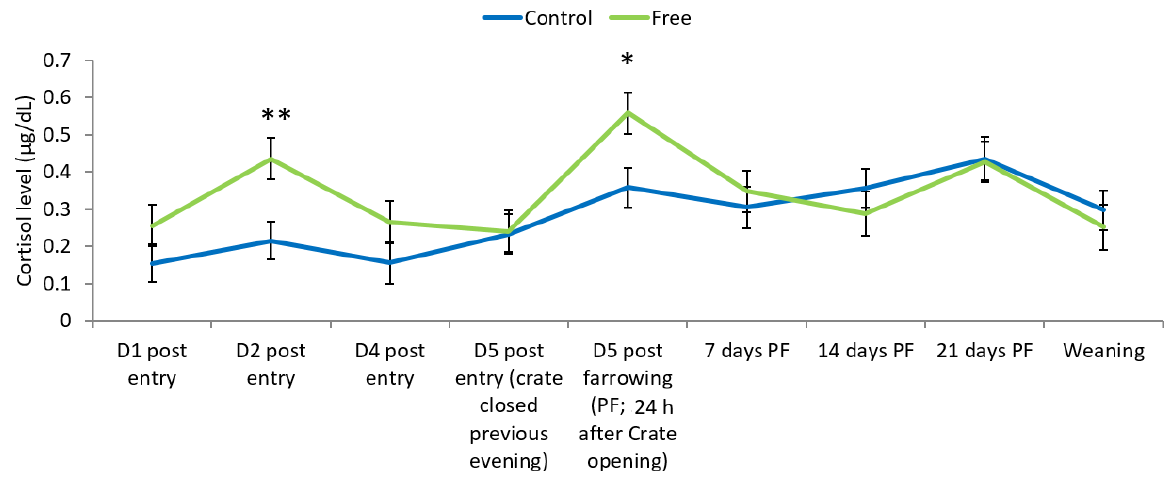
Figure 3. Salivary cortisol levels of sows in the Control (standard farrowing crate) or Free (sows enclosed in a crate from the onset of milk let-down until three days post farrowing) treatments throughout the experiment. Crates were opened three days post farrowing (PF). * indicates a tendency for a difference between treatments ( p < 0.1 > 0.05), and ** indicates a significant difference ( p < 0.05) on that recording day.